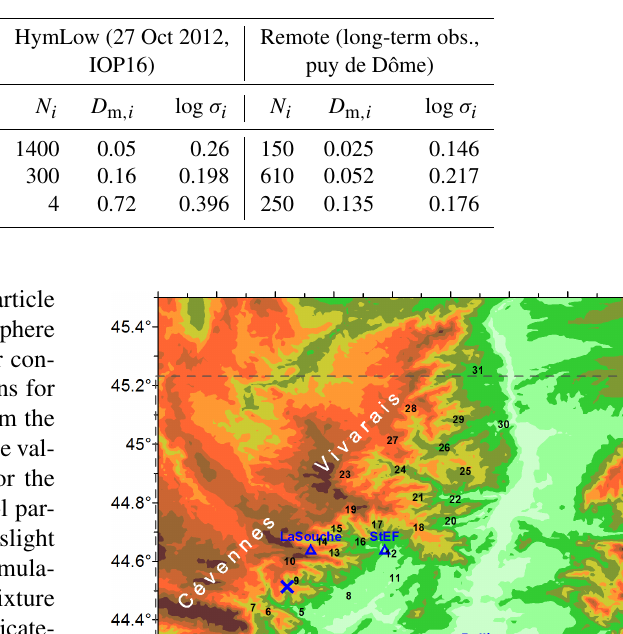
Table 1. Aerosol particle number distributions used for the different modelling scenarios. Each size distribution is composed of three modes ( i ) defined with a log-normal distribution using the number N , the mean diameter D m and the standard deviation σ parameters ( N in cubic centimetres and D m in micrometres).